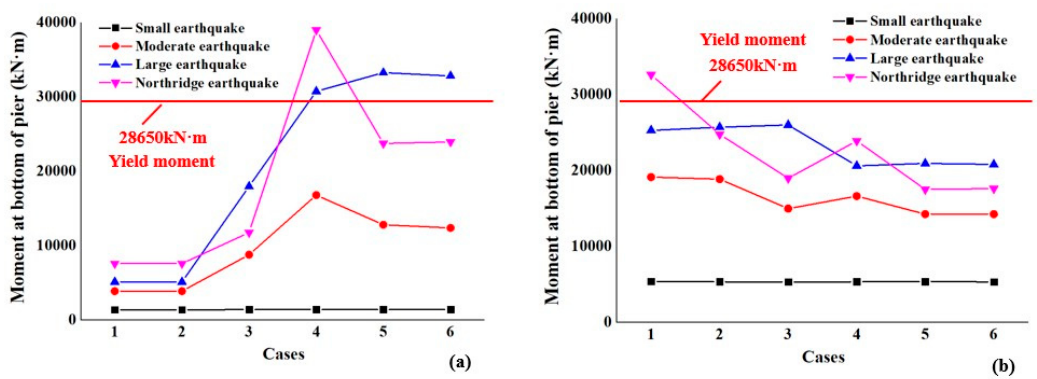
Figure 10. Moment of the pier bottom in di ff erent cases under di ff erent earthquakes: ( a ) side piers and ( b ) middle piers.